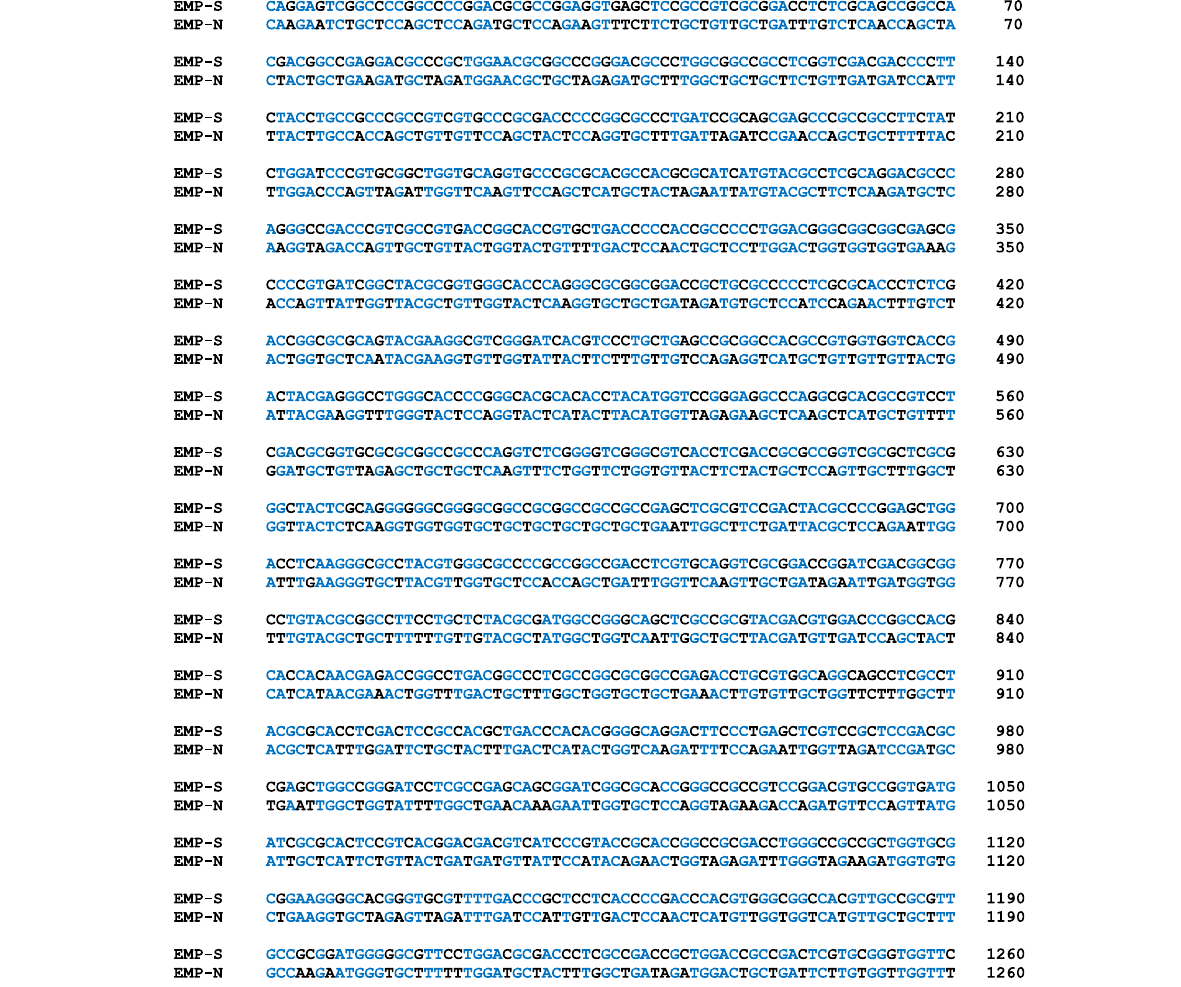
Fig. 1 Alignment of sequence of LipEMP48-D native (EMP-N) and LipEMP48-D synthesis — codon optimization product (EMP-S). The blue highlight is identic